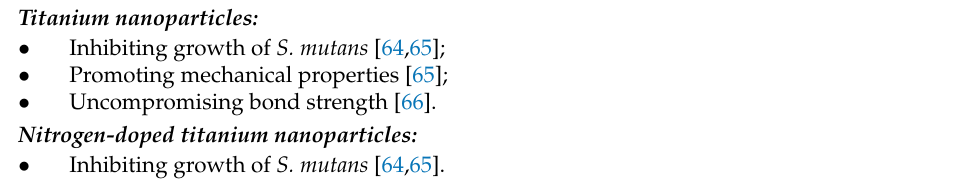
Table 3. Properties of titanium nanoparticles and their related products in caries